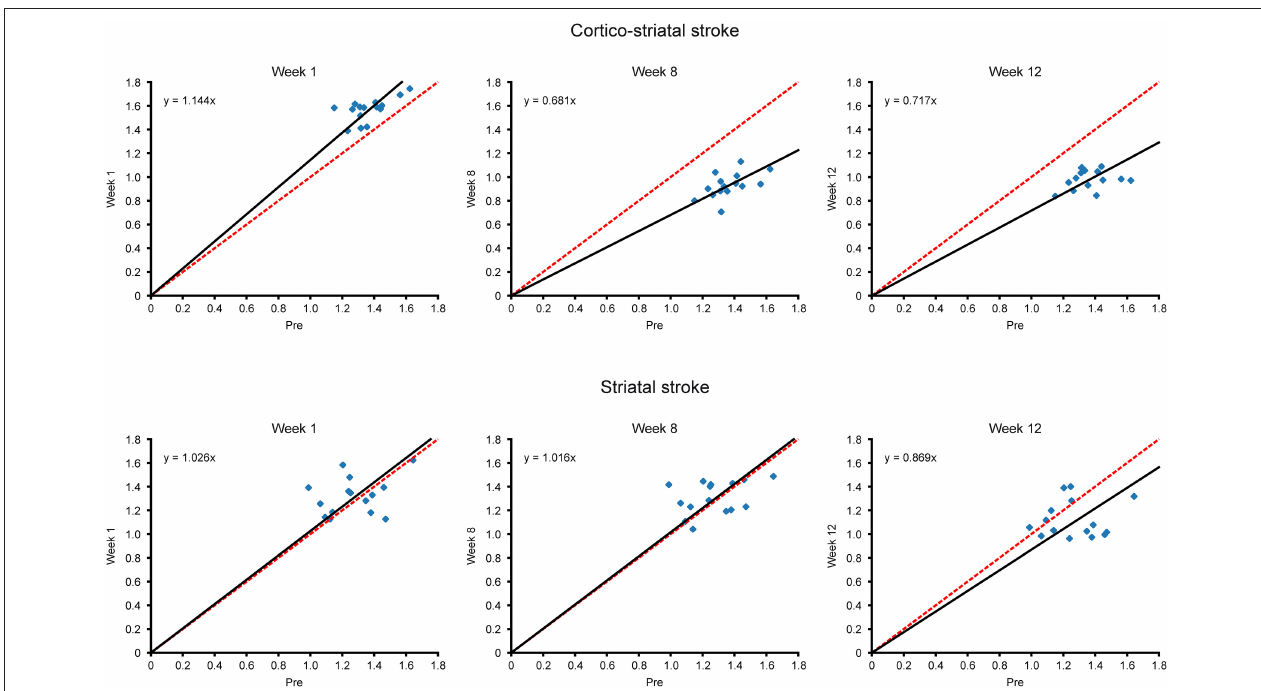
FIGURE 5 | Scatterplots of matrix elements between two time points. The z -score values of all connectivities of the contralateral hemisphere, contained in the matrices of Figure 4 , are compared for different time points with their respective values before stroke induction, as presented in scatter plot diagrams. Deviation of the scatterplots from the identity line is presented for the two time points in each diagram. The identity line indicating no changes for the individual matrix elements between two time points is marked in red, while the fit through the scatter plot and passing through zero is given in black. The slope of the fit, in deviation from slope = 1.000 for the identity line, indicates the overall increase or decrease of the z -score values from the pre-stroke time point to the second selected time point. For the cortico-striatal group (upper row diagrams), the diagram at week 1 shows the slight slope increase (slope wk1 ; cortico − striatal = 1.144) for the hyperconnectivity; at weeks 8 and 12, the slopes have substantially decreased (slope wk8 ; cortico − striatal = 0.681, slope wk12 ; cortico − striatal = 0.717), demonstrating the weakening of the sensorimotor functional network at those times. For the striatal group (lower row diagrams), complete superposition with the identity line is preserved for week 1 and also at the late chronic period at week 8, indicating complete stabilization of the pre-stroke connectivity strength by the neural stem cells (slope wk1 ; striatal = 1.026, slope wk8 ; striatal = 1.016). Only at week 12, here the slope has noticeably decreased to slope wk12 = 0.869, which, however, remains still above the slope of the cortico-striatal group at this time